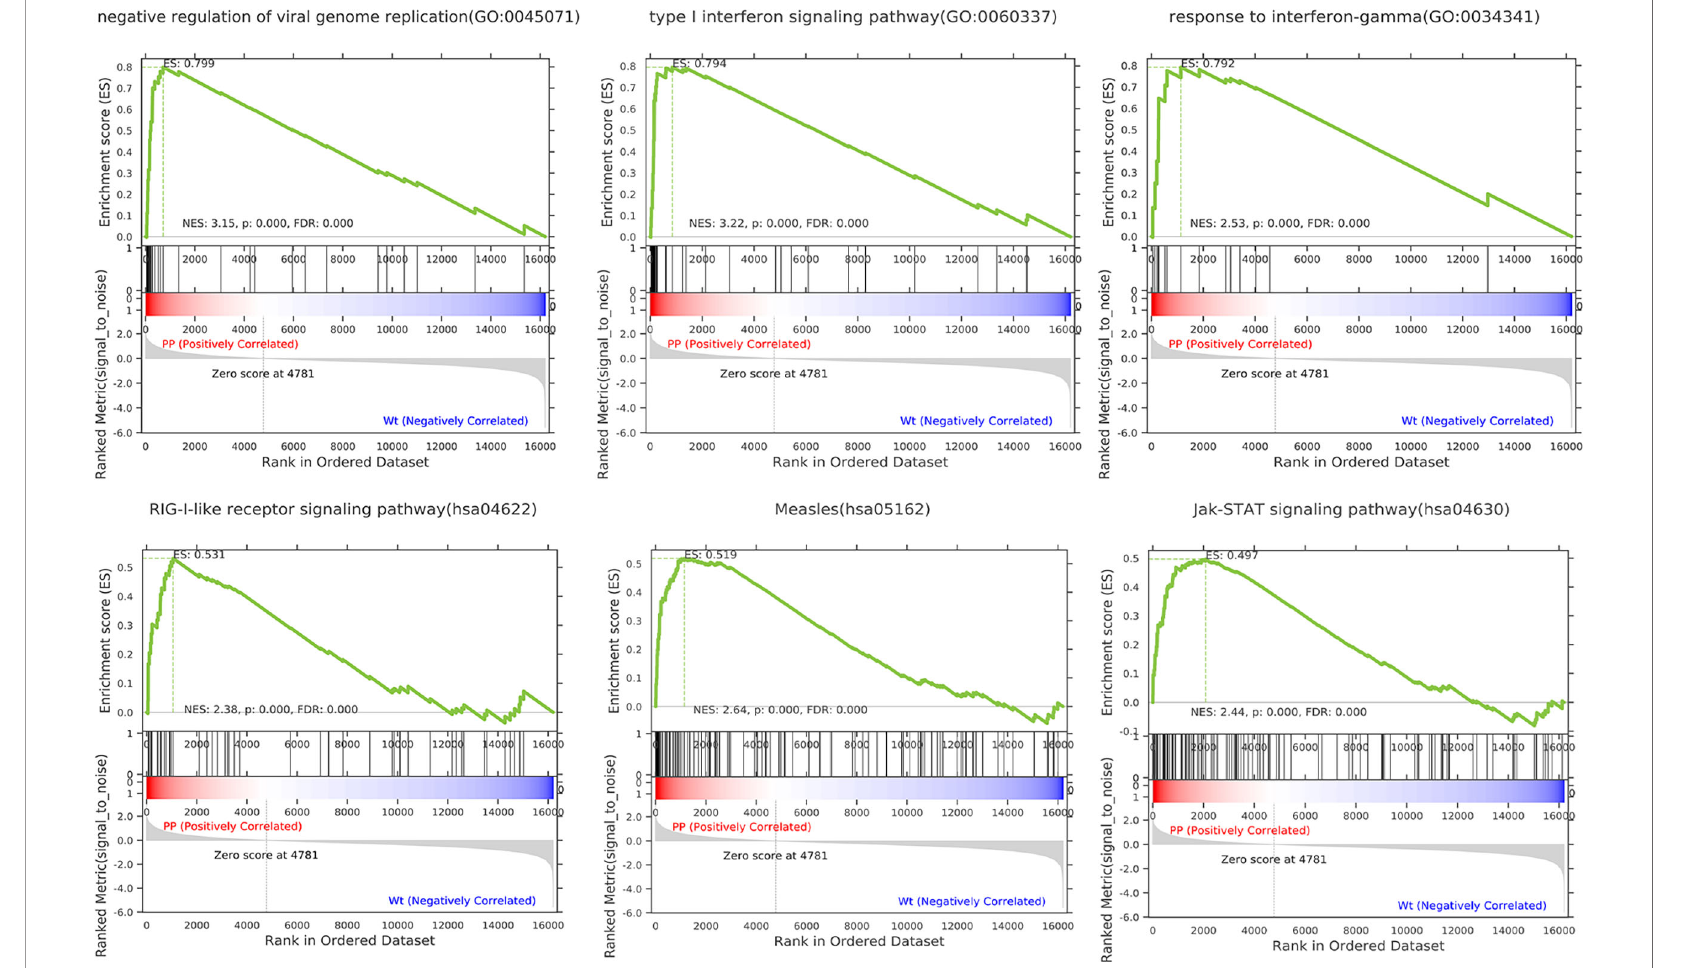
FIGURE 2 | Gene set differences between PPE57-stimulated PBMCs and controls as illustrated through a gene set enrichment analysis (GSEA) approach. Enrichment plots for six GSEA pathways that were enriched in PPE57-stimulated PBMCs relative to controls. A gene set was considered to be signi fi cantly enriched at a P ≤